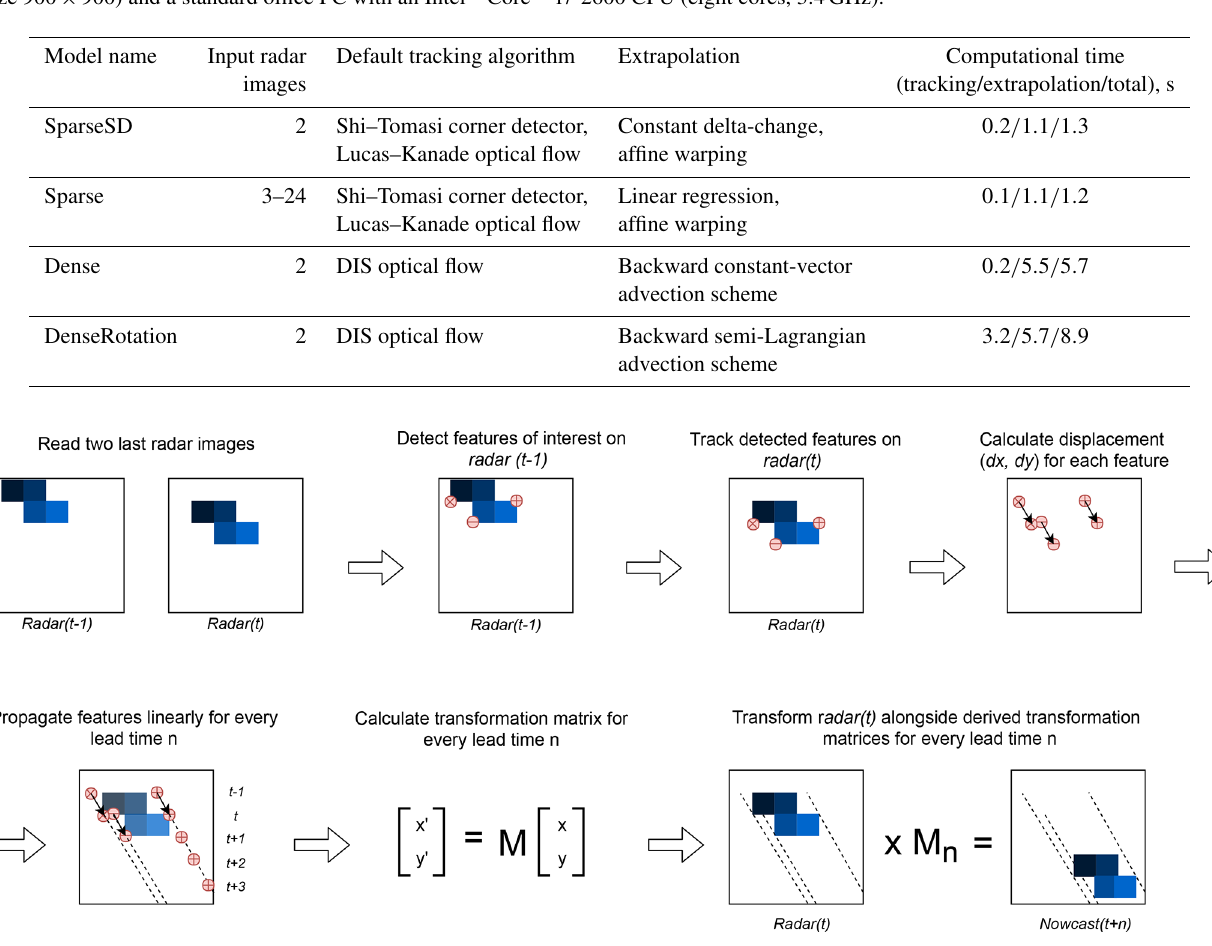
Table 1. Overview of the nowcasting models developed and their computational performance. Nowcasting experiments were carried out for 1h lead time at a 5min temporal resolution (12 resulting nowcast frames in total) using the RY radar data (spatial resolution of 1km, grid